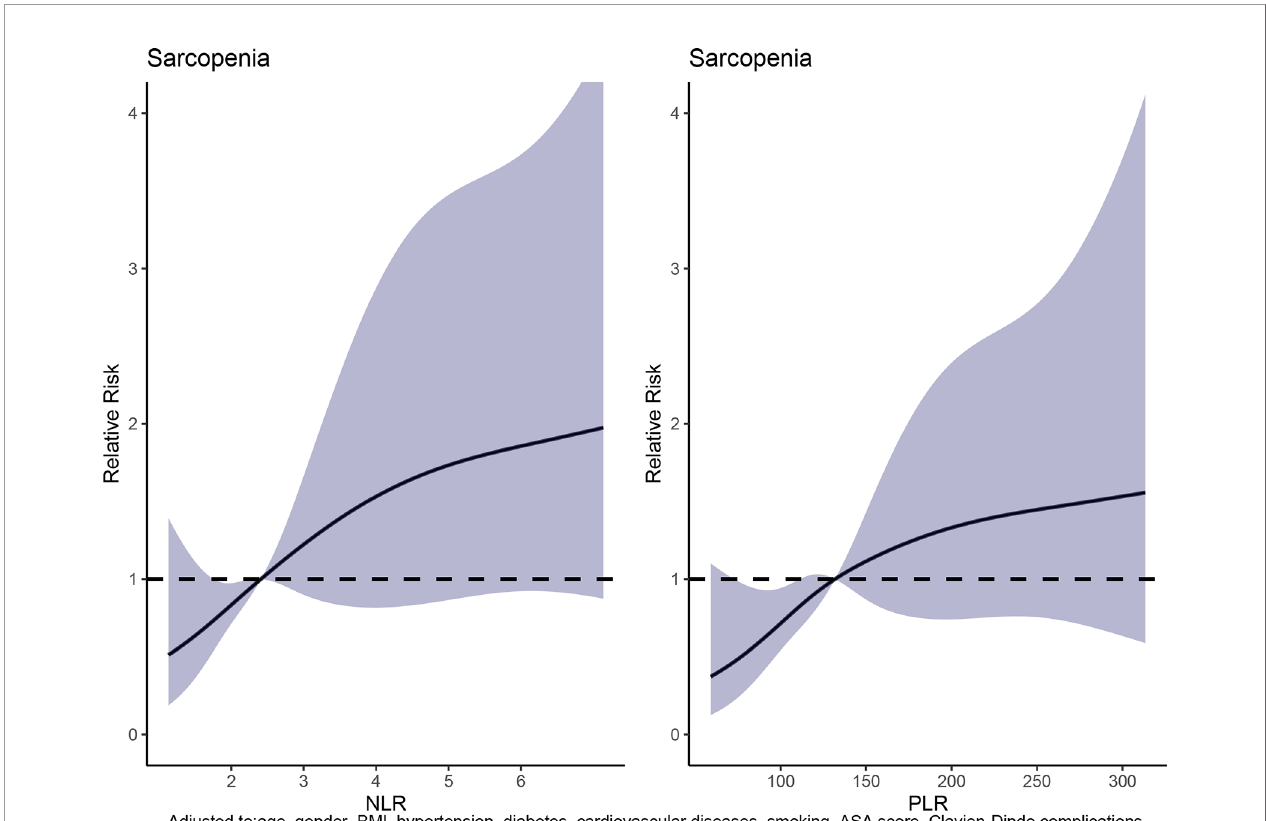
FIGURE 3 | Relationship between NLR and PLR with sarcopenia